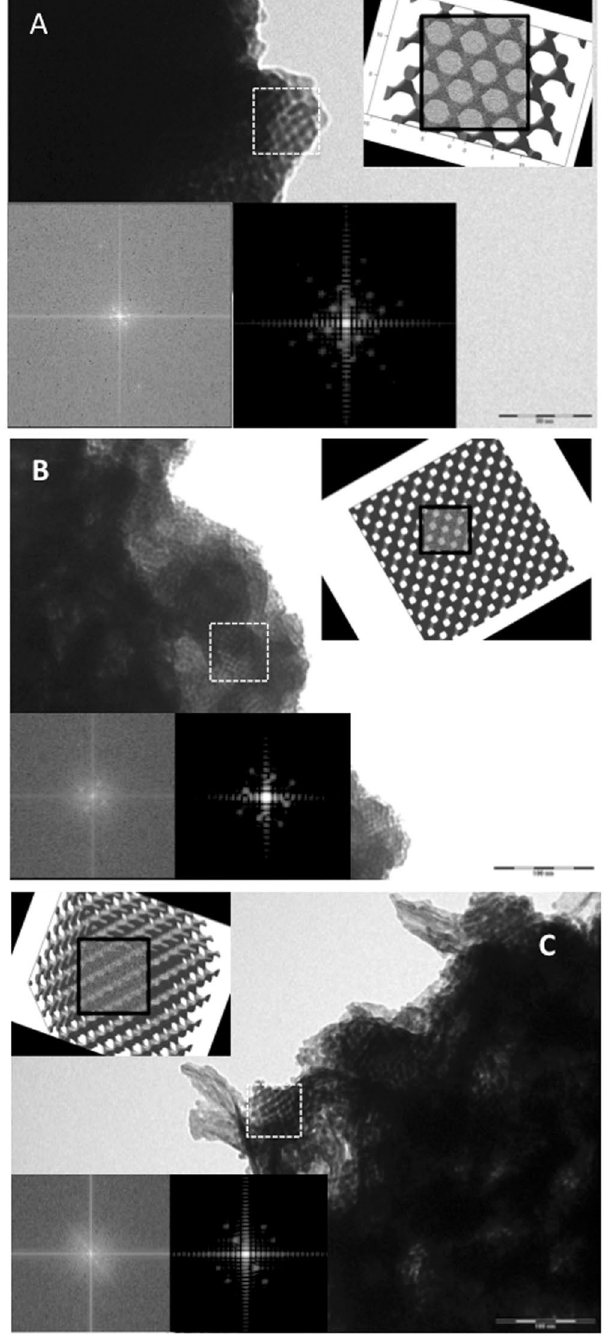
Figure 5. TEM images with corresponding Matlab projections for a single diamond topology nanostructure viewed along the following directions: ( A ) [110], ( B ) [100] and ( C ) non-integer direction perpendicular to [111]. FFTs for each TEM image (bottom left) have been included. For comparison, the corresponding MATLAB projection is shown (top right), with the highlighted rectangular section (with Gaussian noise added artificially) used to produce the corresponding simulated FFT (bottom